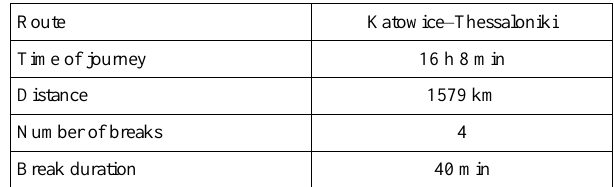
Table 5. Route details generated for ICE vehicle in [8]